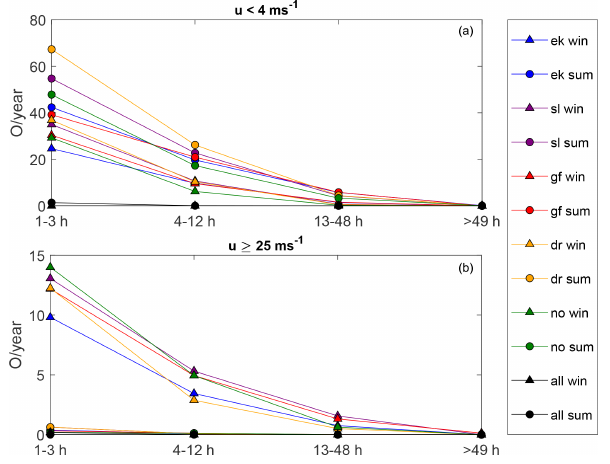
Figure 10. Average number of yearly occurrences ( O per year) of zero wind power production for different durations (1–3, 4–12, 13– 48, and > 49h) both for u < 4ms − 1 (a) and for u ≤ 25ms − 1 (b) . The occurrence of zero power is plotted for winter (triangles) and summer (circles), where the largest differences are